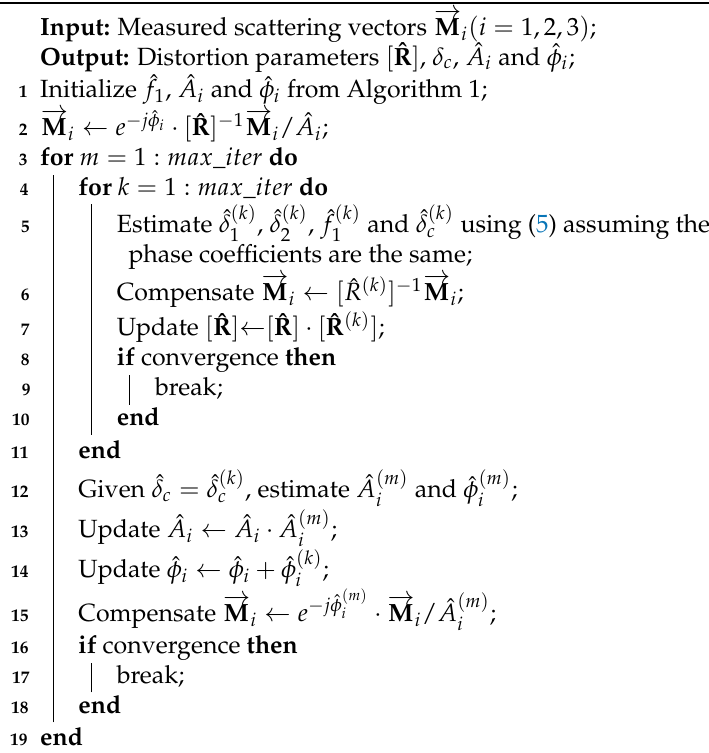
Algorithm 2: CCT calibration